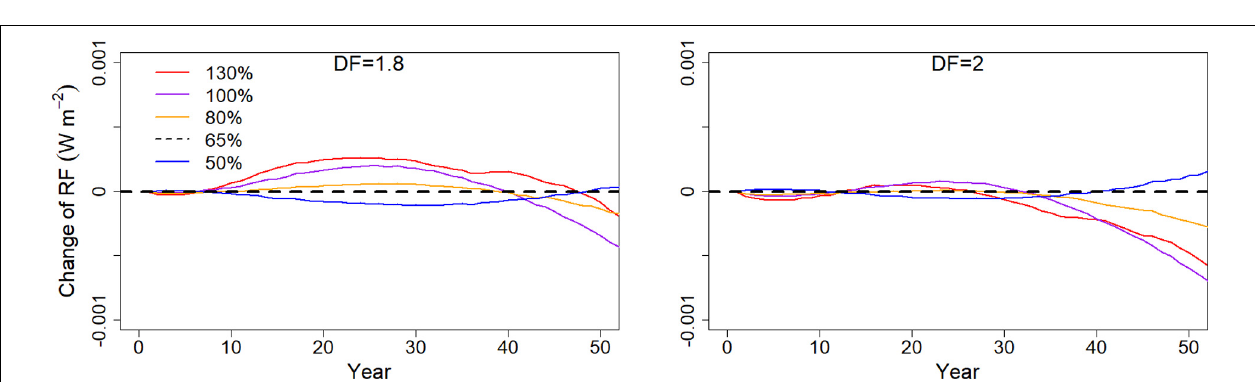
FIGURE 6 | Accumulated radiative forcing over one rotation ( RF T , T = i ... t in Eq. 1) in (A) Norway spruce fertile mesic stand, (B) Scots pine infertile sub-xeric stand, and (C) silver birch herb-rich stand. The RF is defined here as a local change in the radiative energy balance (W m - 2 ) at the tropopause per one square meter in response to the change of the state of 1 m 2 of forest area, negative values denote the cooling effect and positive values the warming effect.